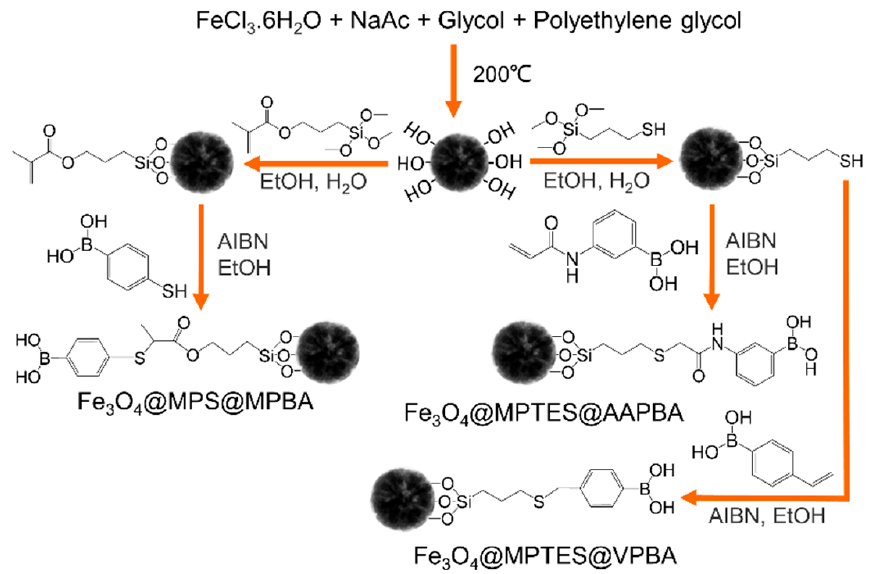
Figure 1. Schematic illustration of synthesis of phenylboronic-acid-modified magnetic nanoparti ‐ cles.